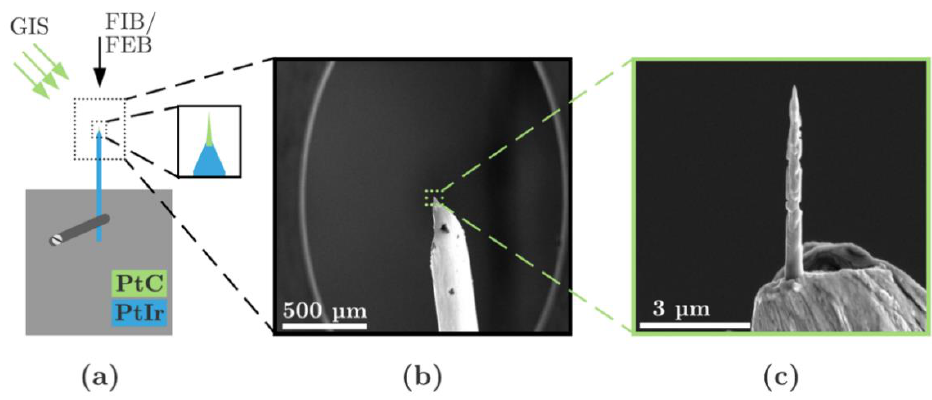
Figure 5. Sample preparation for measurement of PtC electrodes by scanning tunneling microscopy.